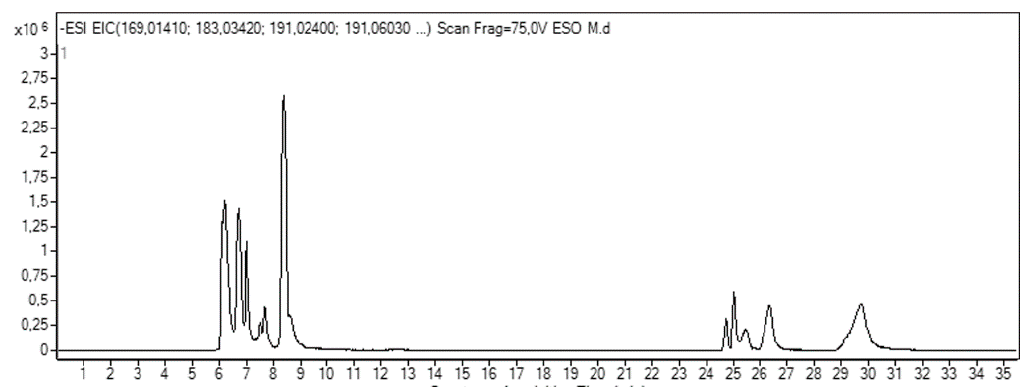
Figure1. Representativehighperformanceliquidchromatography-electrospray-ionization-quadrupole-time of flight (HPLC / ESI / Q-TOF) trace of mango peel extract. MPE presented free polar compounds of all the families. As usually observed for tropical fruits, Figure 1. Representative high performance liquid chromatography-electrospray-ionization- phenolic acid derivatives, in particular the gallic acid derivatives, are abundant. Methyl esters of gallic and quadrupole-time of flight (HPLC/ESI/Q-TOF) trace of mango peel extract. di-gallic acids were the major compounds with concentrations of 487.15 mg / 100 g and 225.87 mg / 100 g, respectively. Gallic acid derivatives have shown high antioxidant activity and health benefits ranging from neuroprotective action [30] to anti-cancer activity in many tumor systems [31]. 3.2. MPE Induces Cytotoxic E ff ects and Morphological Changes in Colon Cancer Cells To estimate the e ff ects of MPE on di ff erent colon cancer cells, we performed cell viability tests using MTT colorimetric assay. For these studies, HT29, Caco-2 and HCT116, three di ff erent colon cancer